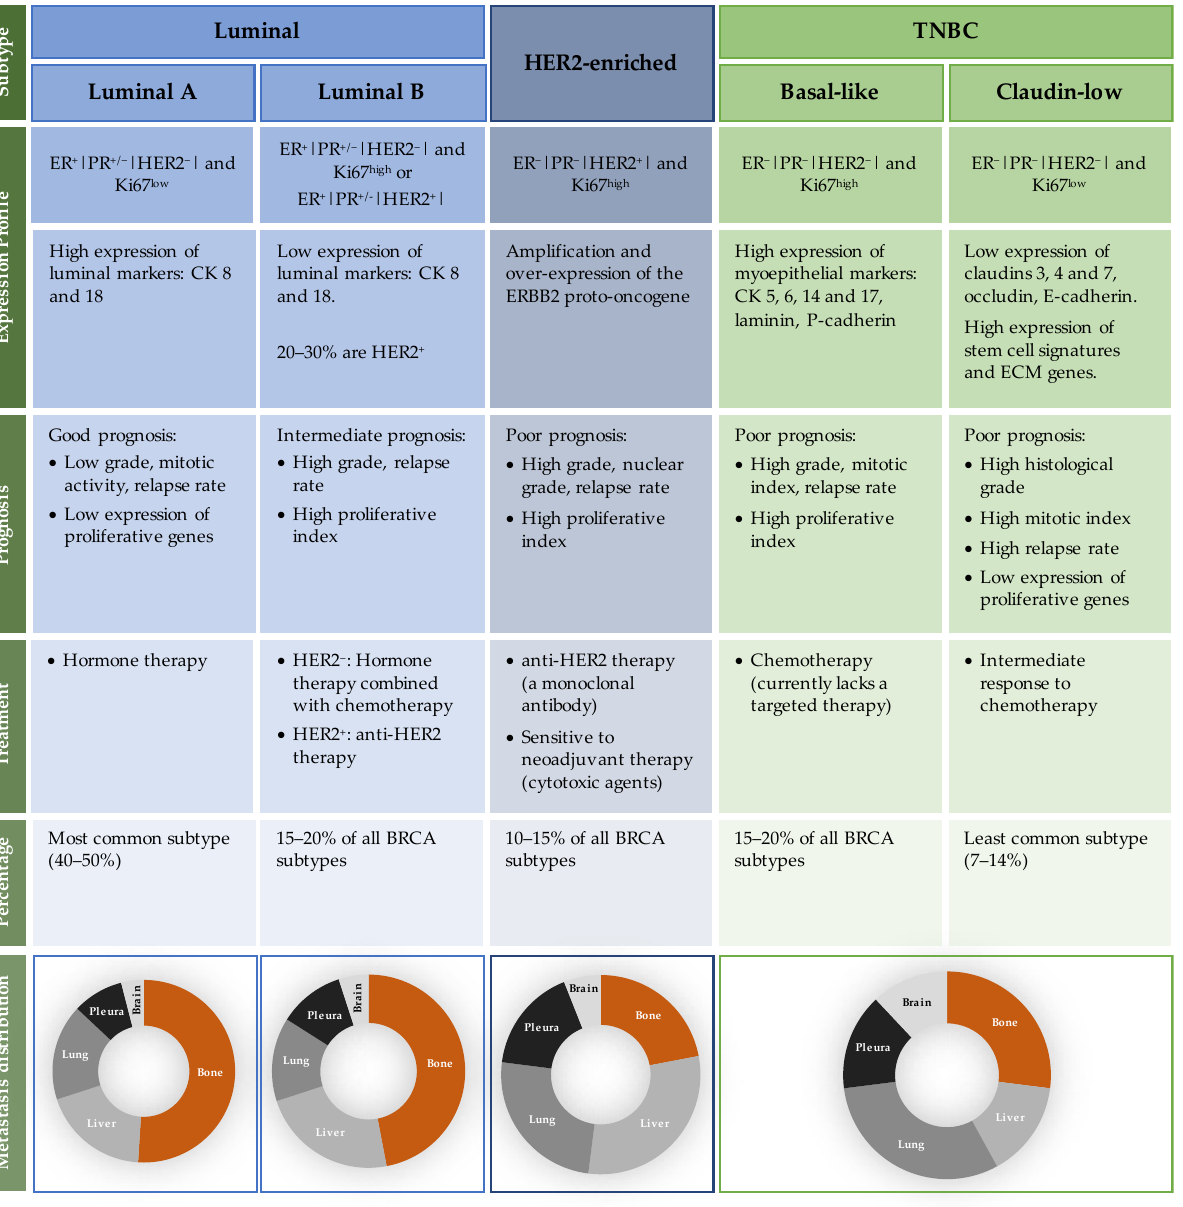
Figure 1. Intrinsic characteristics of each BRCA subtype, in terms of receptor expression profile, prognosis, treatment, percentage of incidence and metastasis distribution. Abbreviations: BRCA— breast cancer; CK—cytokeratin; ECM—epithelial to mesenchymal transition; ER—oestrogen receptor; ERBB2—human epidermal growth factor receptor-type 2; HER2—human epidermal growth factor 2; Ki 67—antigen Ki-67; PR—progesterone receptor; TNBC—triple-negative breast